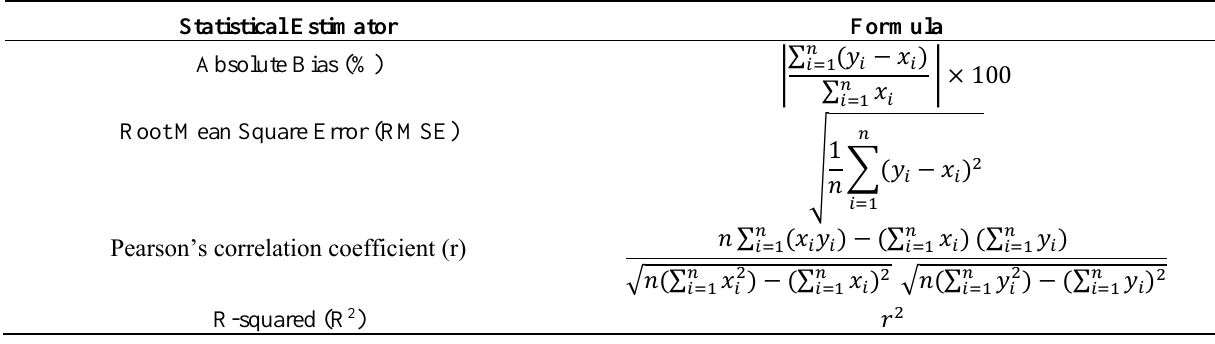
Table 2. Statistical criteria for algorithm evaluation and matchup